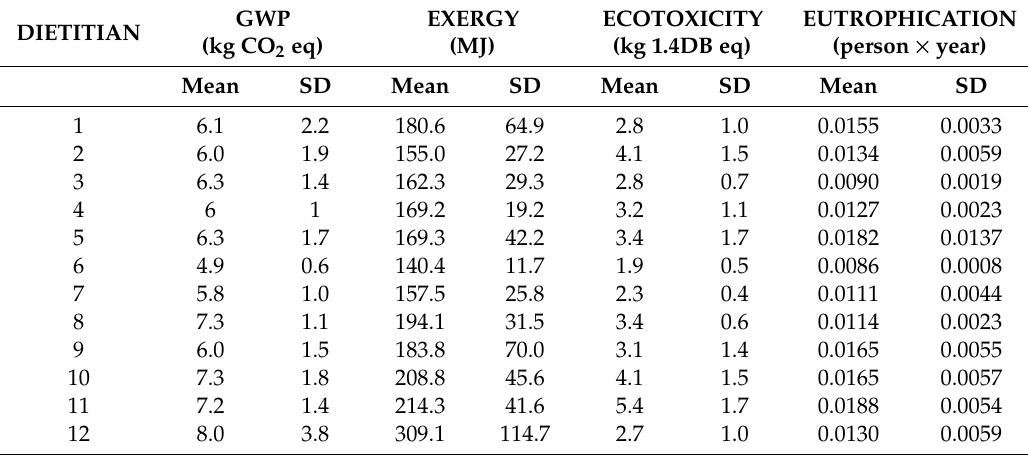
Table 3. Standard deviation of the environmental impacts of the 12 dietitians (easy, moderate and hard plates) for daily totals (sum of breakfast, lunch and